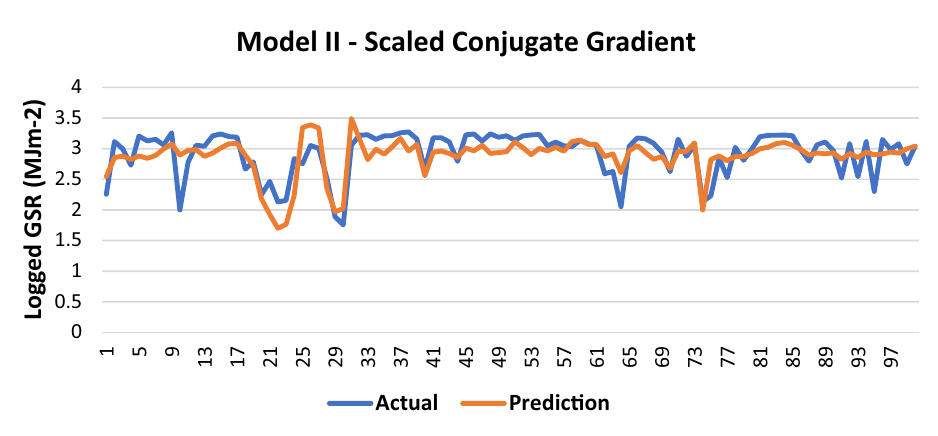
Figure 7. Graph of Actual and Predicted GSR (Model